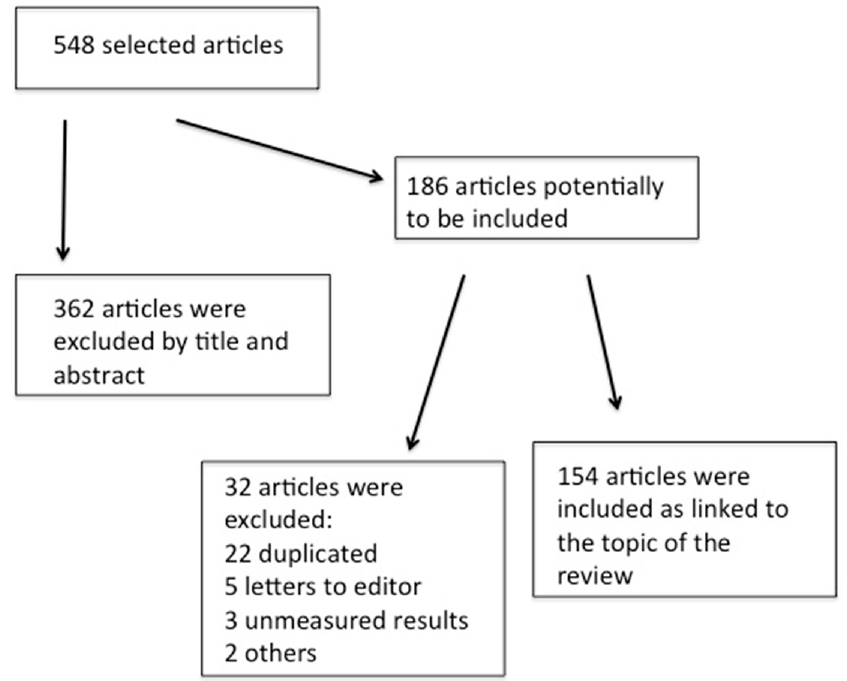
Figure 1. Included and excluded references screened for the literature